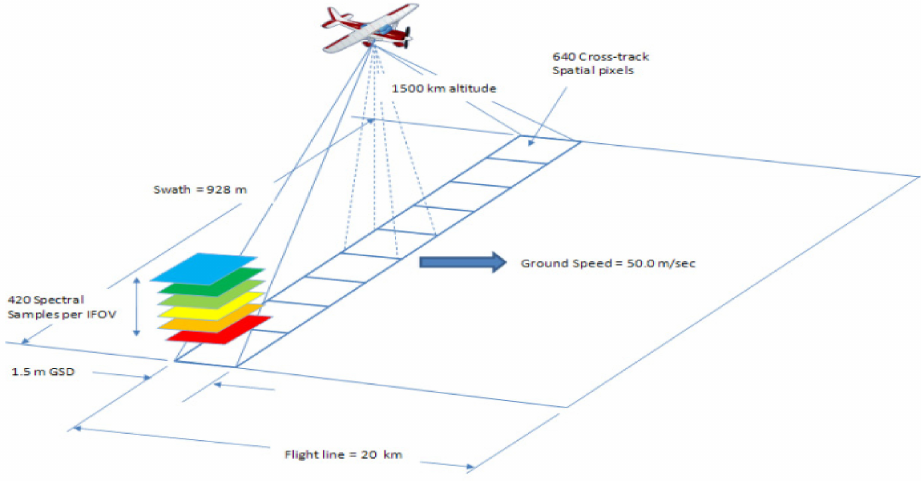
Figure 8. Flight Geometry of NEON Imaging Spectrometer (NIS)